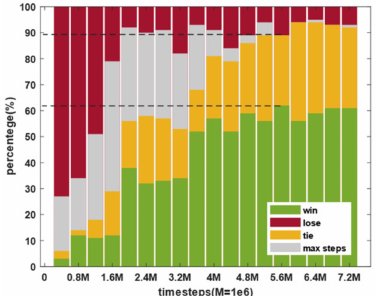
Figure 17. Air combat confrontation results.